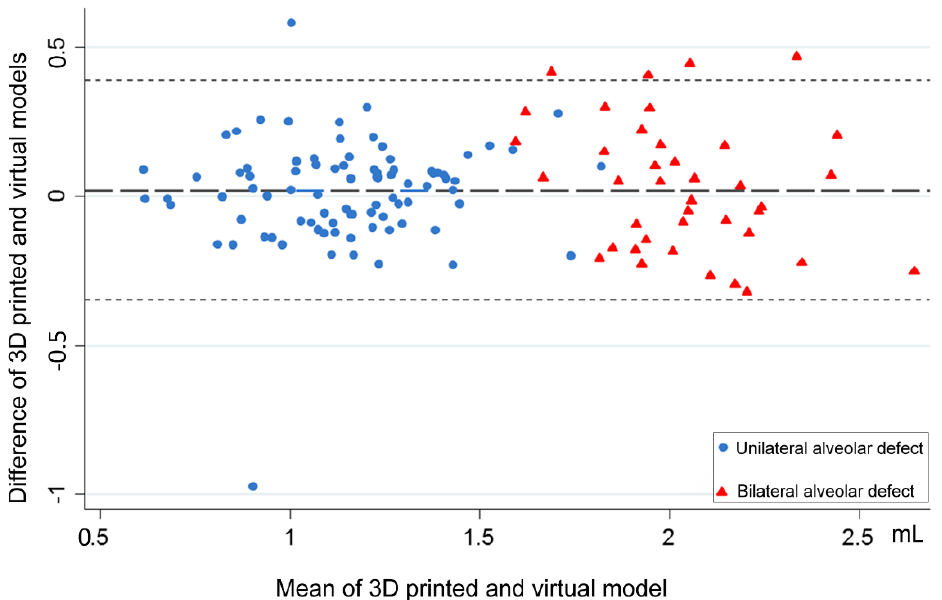
Figure 3. Bland – Altman plot indicating that the mean values of the difference in the volume of the alveolar defect between 3D-printed and virtual-based surgical simulation methods are approximately at the zero-line and are equally distributed within the zero-line, revealing that the two methods produced similar results.